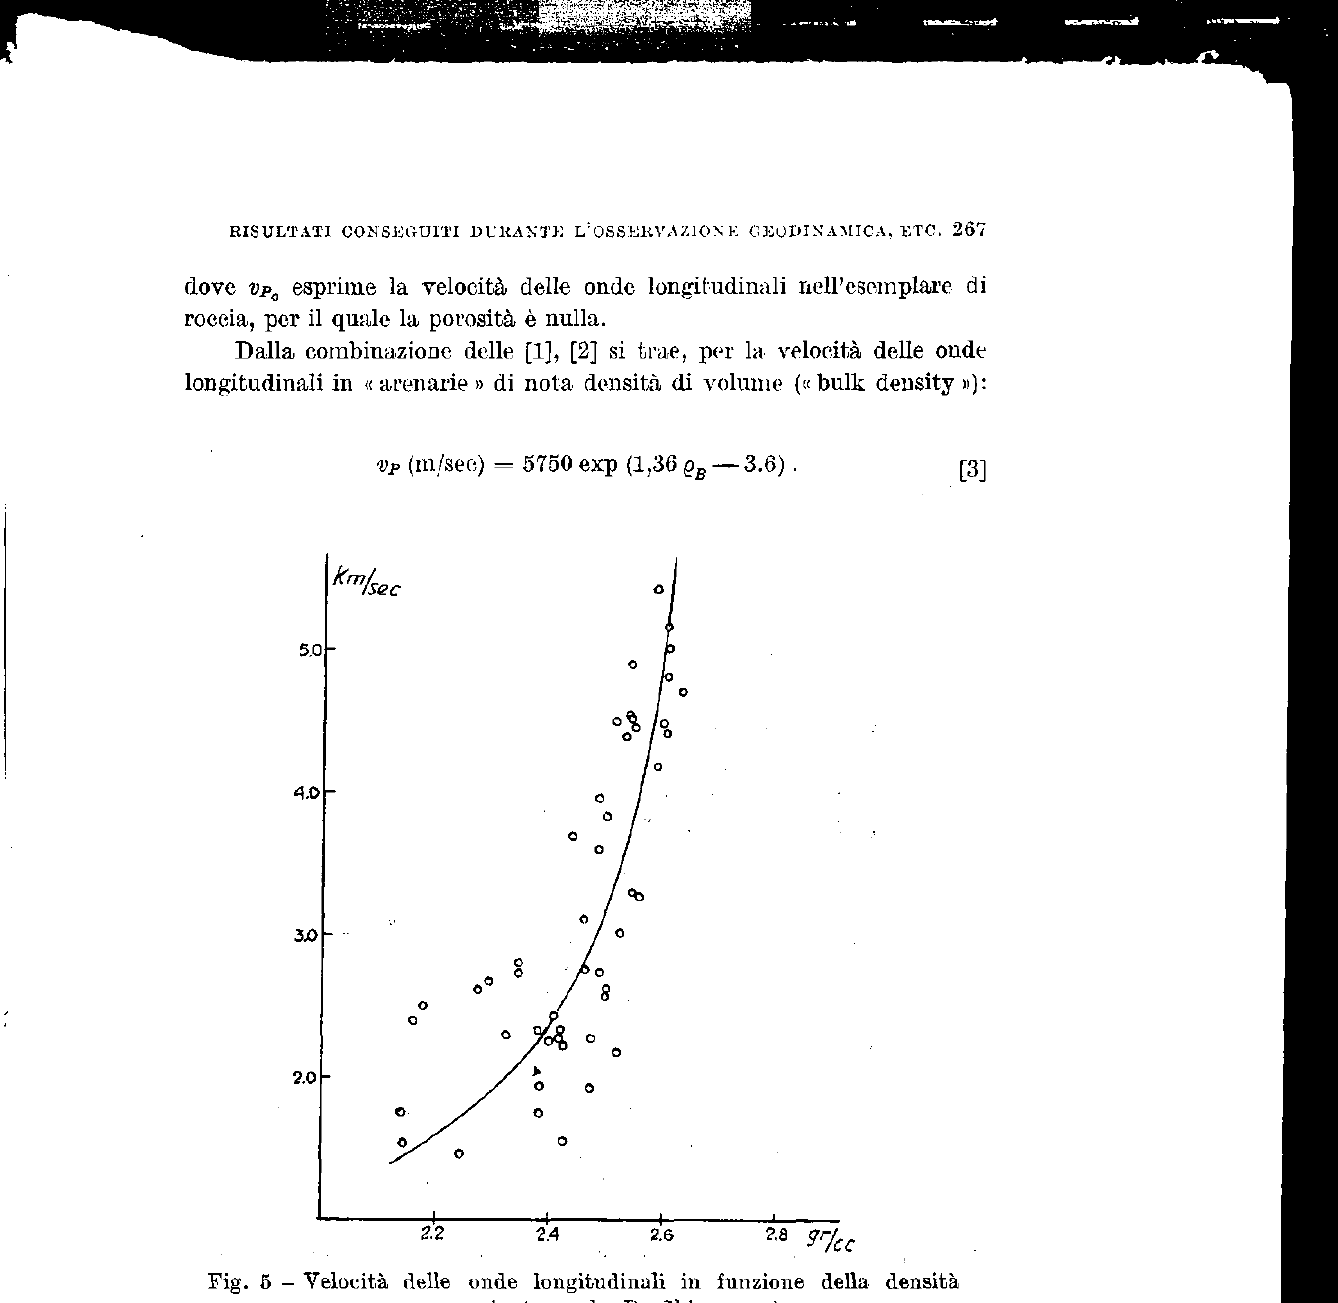
Fig. 5 - Velocità delle onde longitudinali in funzione della densità per arenarie (secondo D.